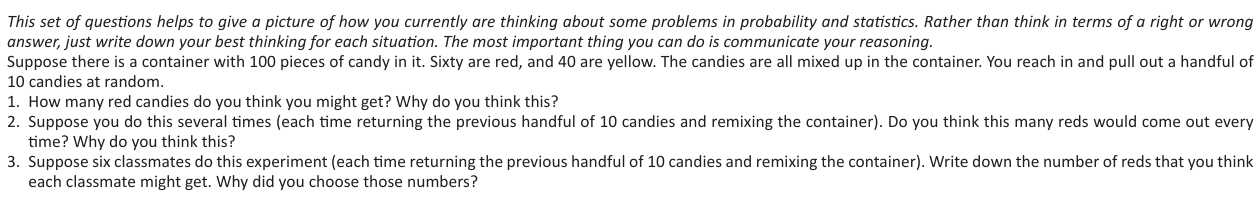
FIGURE 2: The Candy Bowl